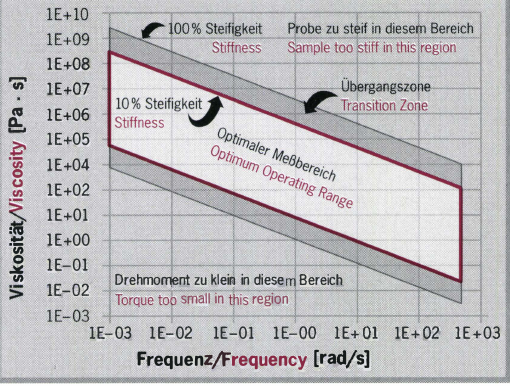
Fig. 5: System setup of a stress controlled